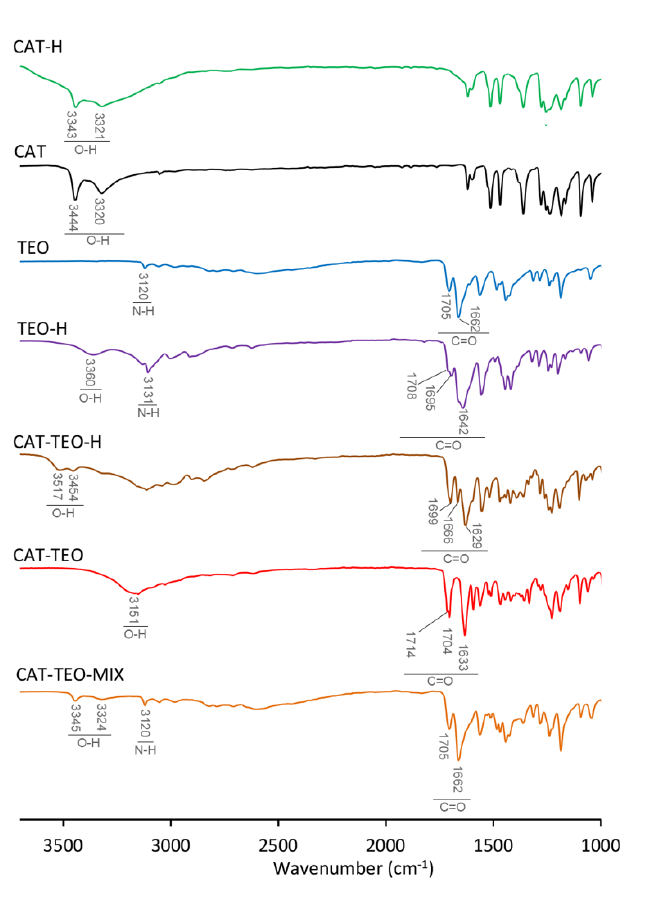
Figure 2. IR spectra of CAT-H (catechol ground with water), CAT (catechol), TEO (theophylline), TEO-H (theophylline ground with water), CAT-TEO-H (catechol and theophylline ground with water), CAT-TEO (catechol and theophylline ground with dichloromethane), and CAT-TEO-MIX (physical mixture of catechol and theophylline).